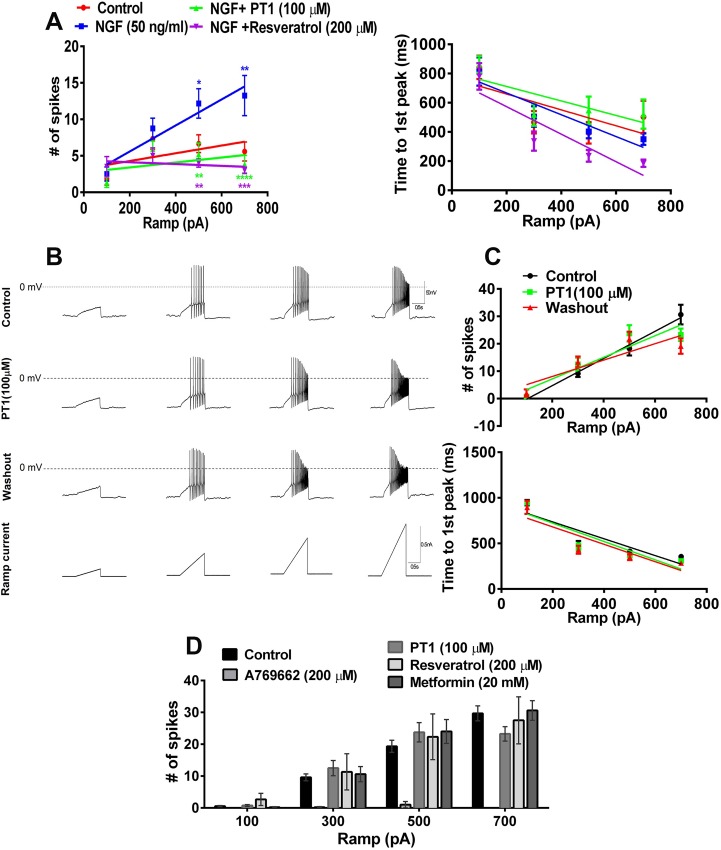
PT1 and resveratrol inhibit NGF-induced hyperexcitability but have no acute effect on action potential firing.(A) Patch clamp analysis of rat TG neurons cultured in the presence of NGF (50 ng/ml, n = 11) show an increase in the number of ramp evoked action potentials compared to control (n = 8) which is reversed by PT1 (100 μM; 1 hr, n = 11) and resveratrol (200 μM, 1 hr, n = 6). Colored stars denote significant effects compared to NGF group. * p < 0.05, ** p < 0.01, *** p < 0.001 and **** p < 0.0001. (B) and (C) Acute application of PT1 (30 μM, n = 10; 100 μM, n = 8) demonstrates no influence on action potential firing compared to control. The number of ramp current evoked action potentials was normalized to control. (D) Acute application of other AMPK activators (resveratrol, 200 μM, n = 6; metformin, 20 mM, n = 6) does not block VGSCs.